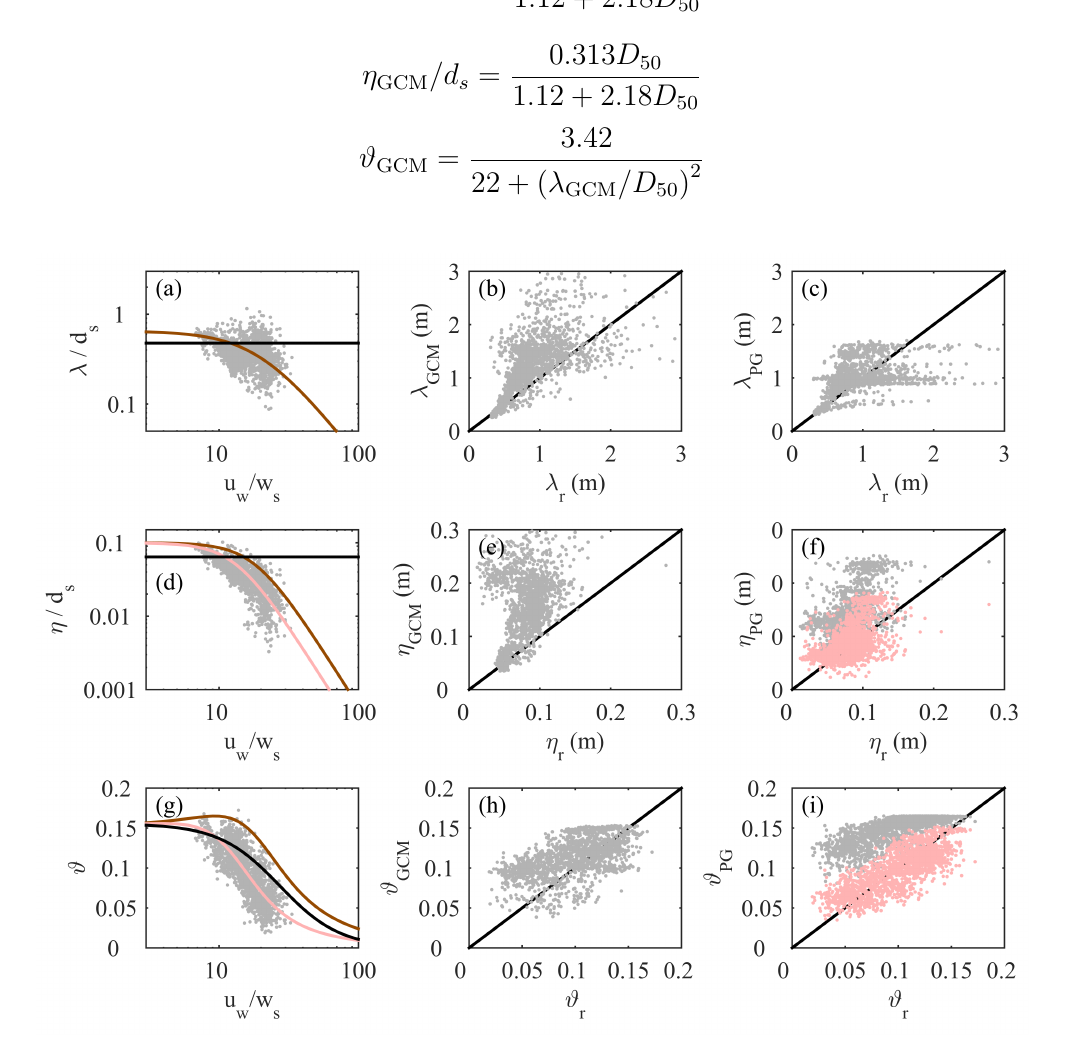
Figure 12. Measured ( a ) normalized ripple length λ and ( g ) ripple steepness ϑ sediment fall velocity w GCM and PG predictors, respectively; in ( g ), T predictor. Other panels are scatter plots of predicted against measured ripple parameters together with the 1:1 line. The light-red lines in ( d ) and ( g ), and the light-red dots in ( f ) and ( i ) correspond to the modified PG η/d